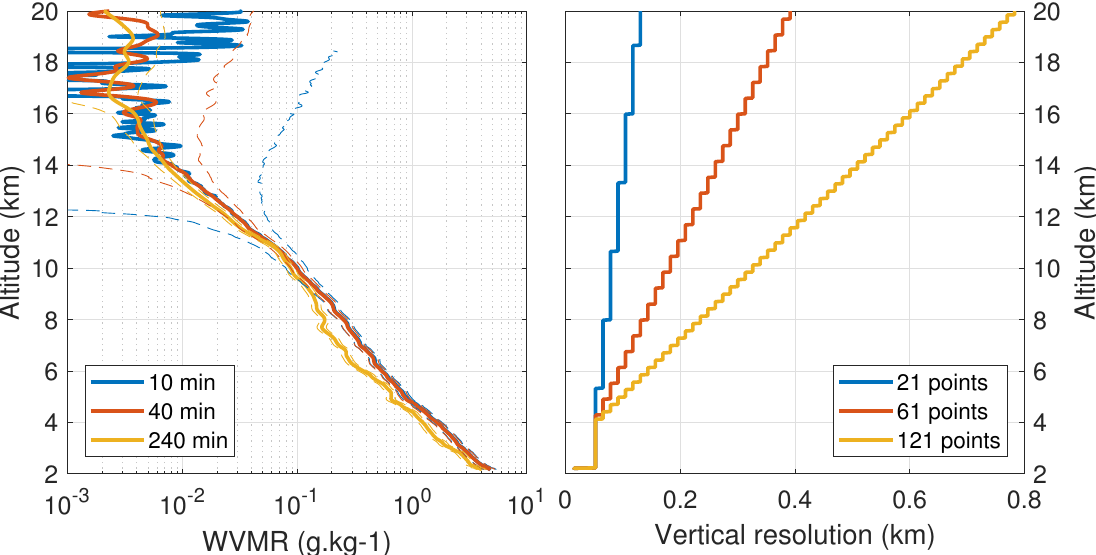
Figure 4. Mean profiles integrated over 10 min (solid blue line), 40 min (solid orange line) and 240 min (solid yellow line) with their total uncertainty (dotted lines) ( left ), and the associated vertical resolution ( right ) according to the altitude above sea